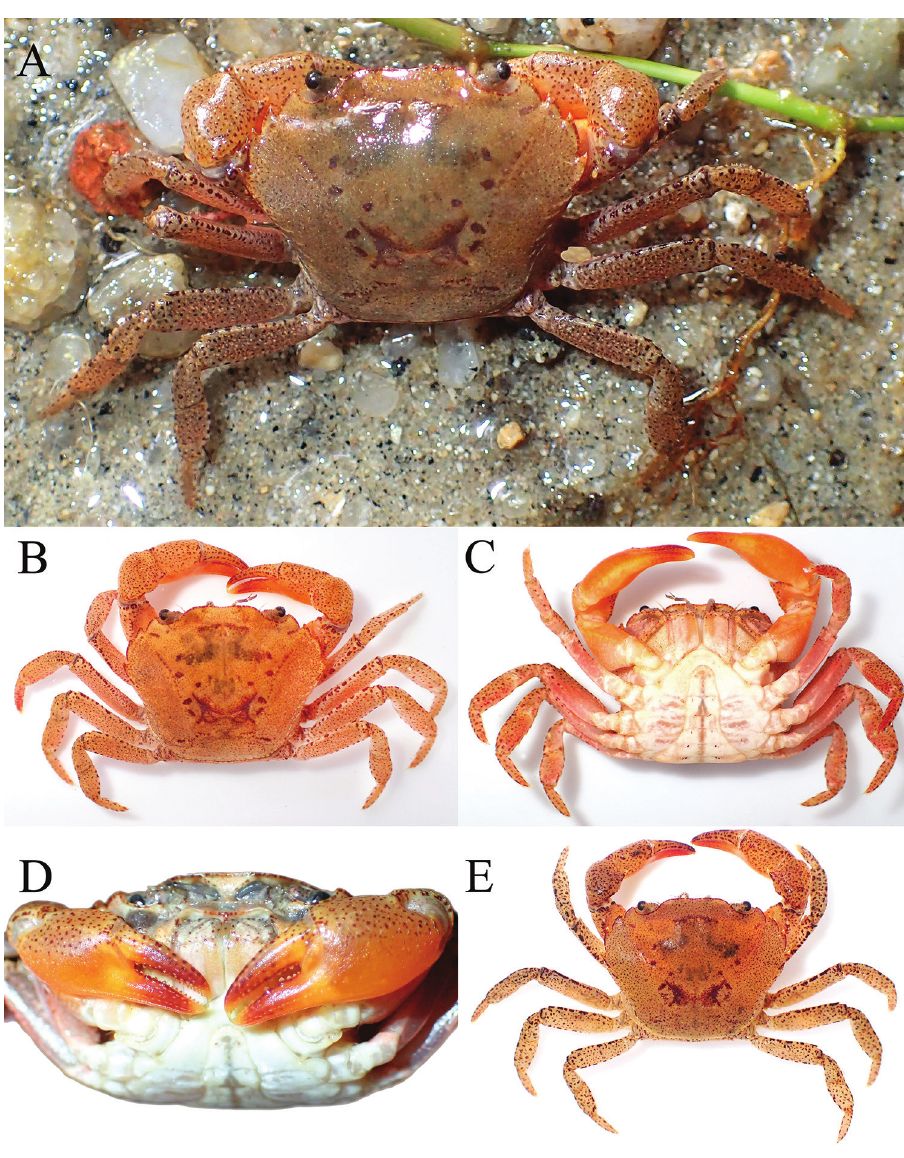
Figure 5. Salangathelphusa peractio sp. n., colour in life. A–D male (22.4 × 17.7 mm) (ZRC 2017.210) E male (21.9 × 17.3 mm) (ZRC 2017.210), Langkawi. ambulatory leg has a small dorsal subdistal spine and the male pleonal somite 6 is proportionately more trapezoidal in shape (Fig. 4A, B). Colour. In life, Salangathelphusa peractio sp. n. is light brown to orange on all its dorsal surfaces; the dorsal surface of the carapace has large reddish-brown spots and markings at or near the cervical and gastro-cardiac grooves; and the chelipeds and